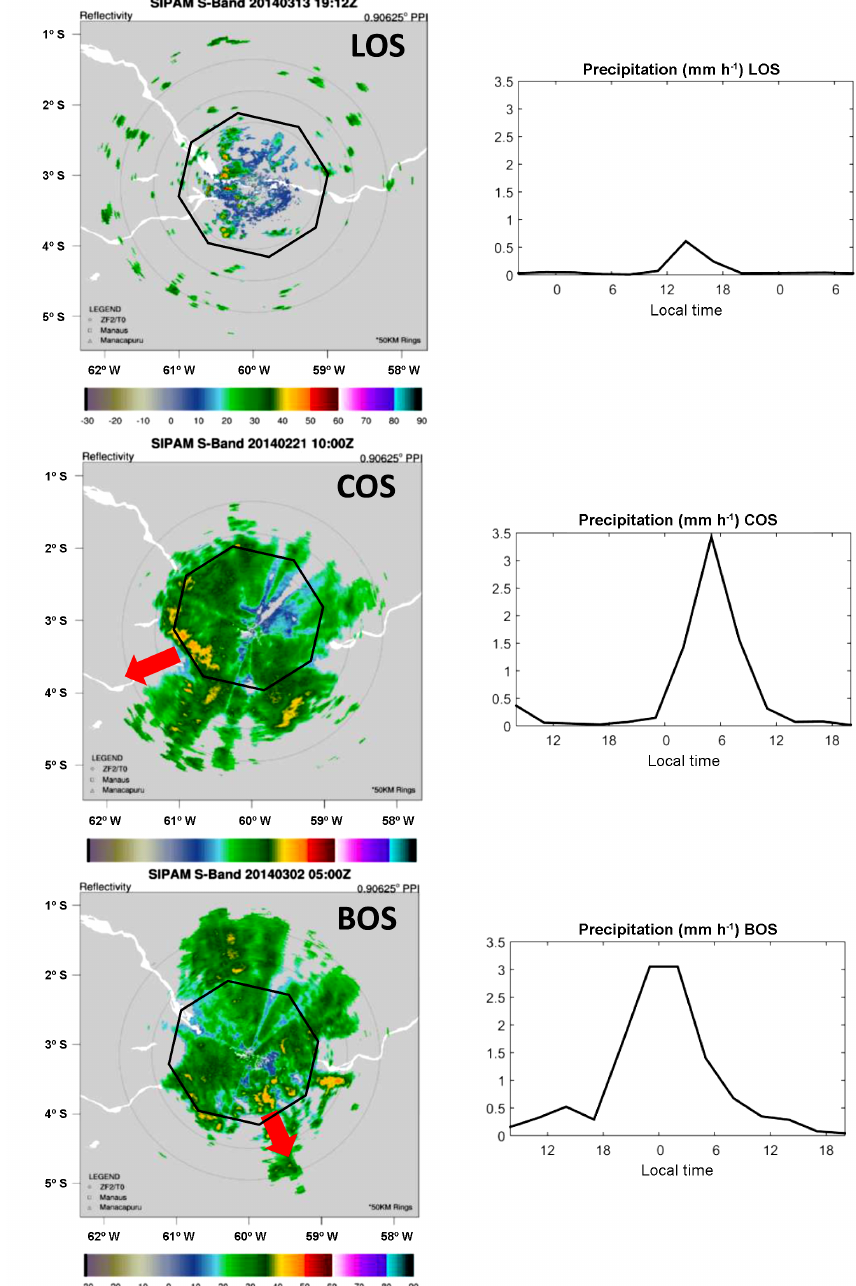
Figure 9. SIPAM radar reflectivity snapshots (left) and time series of domain-mean precipitation (right) for three cases of precipitating systems. From top to bottom: LOS, COS and BOS. The black octagons indicate the GoAmazon domain, and the red arrows indicate the propagating direction of the